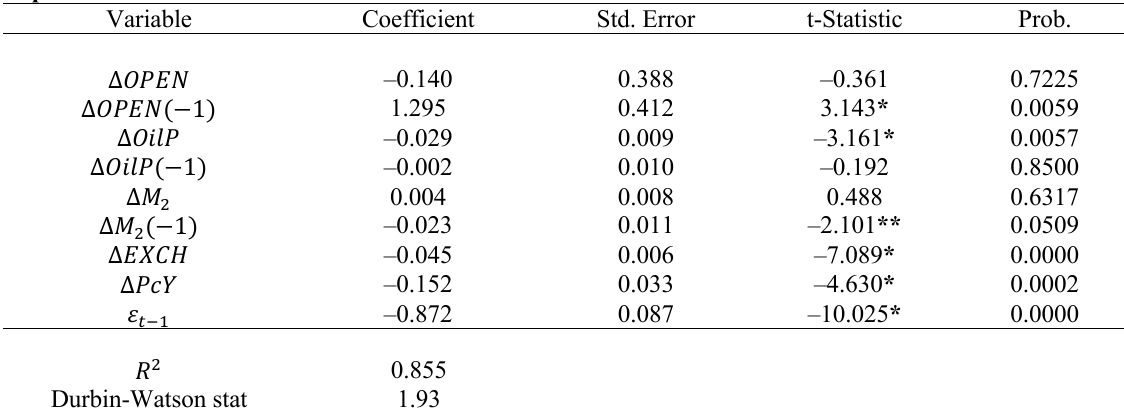
Table 4: Short-Run Estimates Dependent Variable: ∆𝑙𝑛𝑃